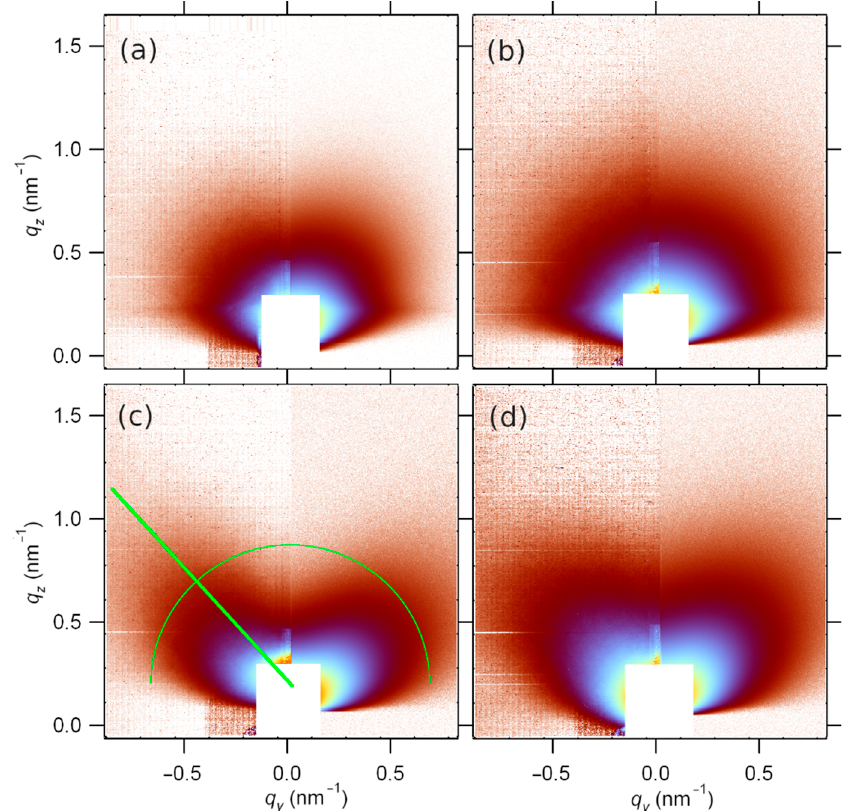
Figure 5. GISAXS pattern for SnO2 single- and double-layer films on glass substrate for a grazing angle of incidence equal to α c + 0.1 ◦ : ( a ) S-610, ( b ) S-590, ( c ) B-610, ( d ) B-590. The left side of each subfigure represents experimentally obtained data, and the right side represents the result of the theoretical model application. The green line and semicircle indicate the positions where the scattered intensity variation is extracted and presented in Figures 6 and 7. The white rectangle at the q space origin marks the detector area covered by an Al beamstop in order to protect the detector from a very strong directly reflected X-ray beam.